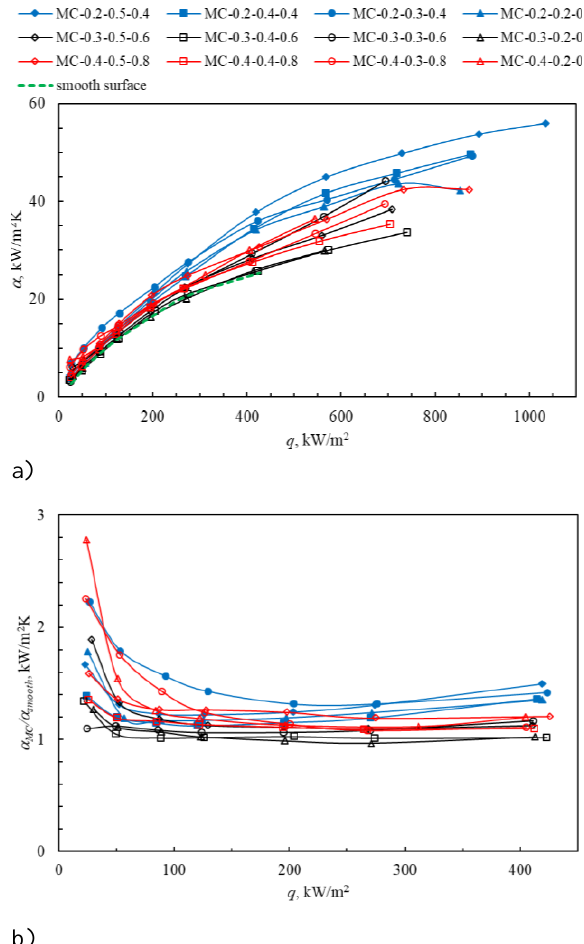
Fig. 3. Boiling curves for ethanol, a) heat transfer coefficient vs. heat flux, b) data in the non-dimensional form for MC surfaces.